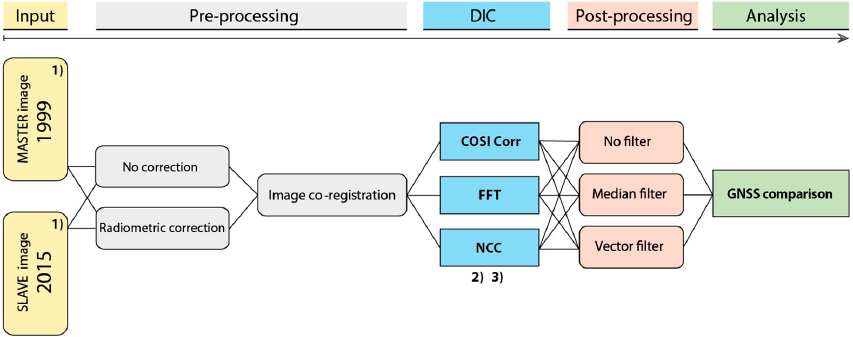
Figure 2. Adopted workflow for this study; (1), (2), and (3) denote possibilities for oversampling, as described in the text.